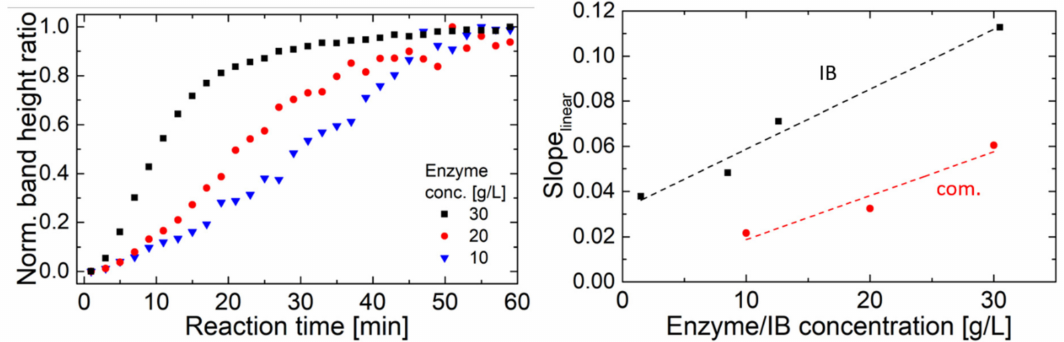
Figure 5. ( a ) degradation behavior of commercially available enzyme, ( b ) linear part of the slopes of the degradation curves vs. concentration of the